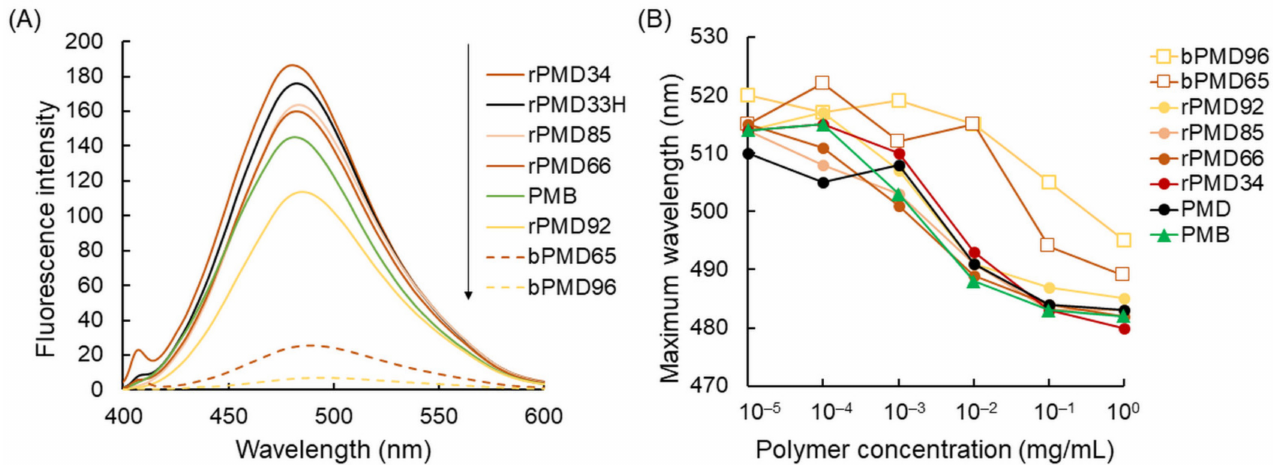
Figure 2. Hydrophobicity estimated using sodium 1-anilino-8-naphthalene sulfonate (ANS). ( A ) Fluorescence spectra of ANS in MPC solutions at 1 mg/ml. ( B ) Maximum wavelength of ANS at various MPC polymer concentrations.